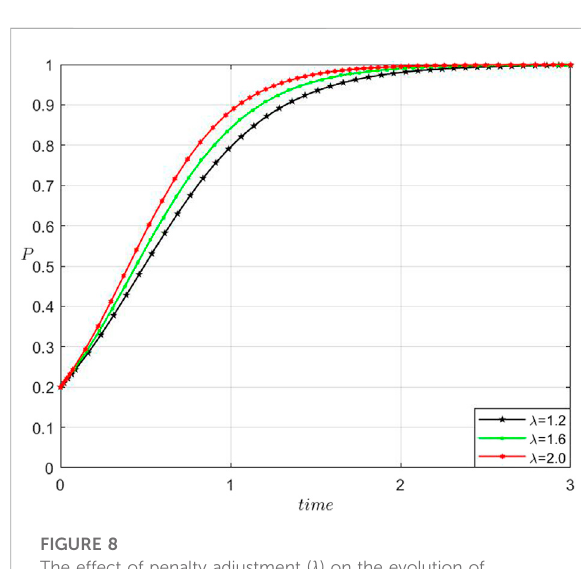
FIGURE 8 The effect of penalty adjustment ( λ ) on the evolution of